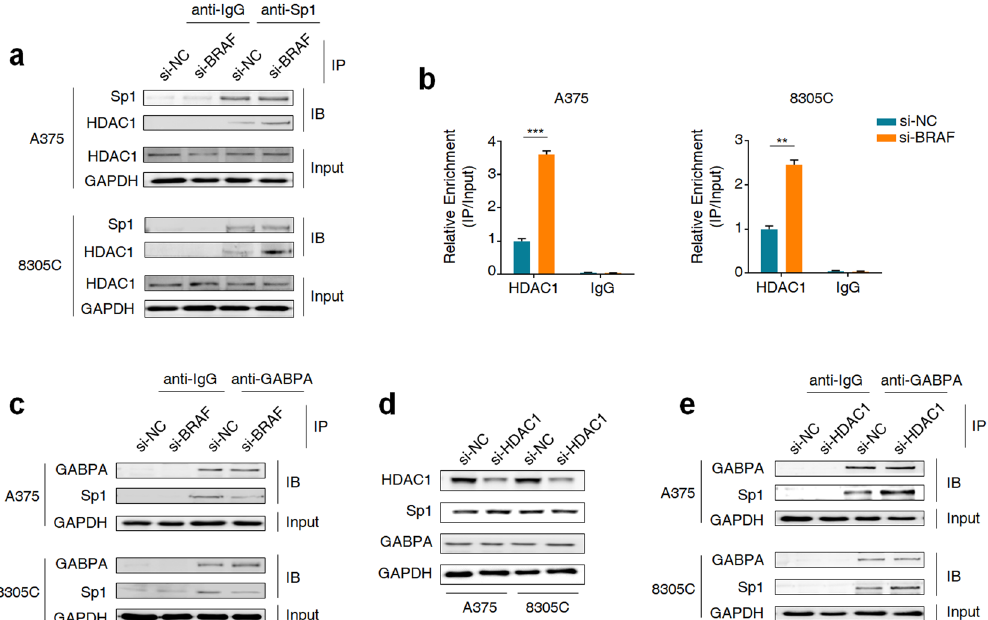
Fig. 3 HDAC1 poses steric hindrance for the interaction between GABPA and Sp1. a Co-IP assay of whole-cell lysates derived from the indicated cells knocking down BRAF and control cells to validate the interaction between Sp1 and HDAC1. b ChIP-qPCR assay was performed to evaluate the effect of inhibition of BRAF V600E -mediated ERK activation on the binding of HDAC1 to TERT promoter in the indicated cells knocking down BRAF and control cells. c Co-IP assay was similarly performed in the indicated cells knocking down BRAF and control cells to validate the interaction between Sp1 and GABPA. d Western blot analysis was performed to determine the effect of HDAC1 knockdown on the expression and GABPA and Sp1 in the indicated cells. e Co-IP assay was performed to determine the effect of HDAC1 knockdown on the interaction between Sp1 and GABPA. Data were shown as mean ± SD. ** P < 0.01; *** P <